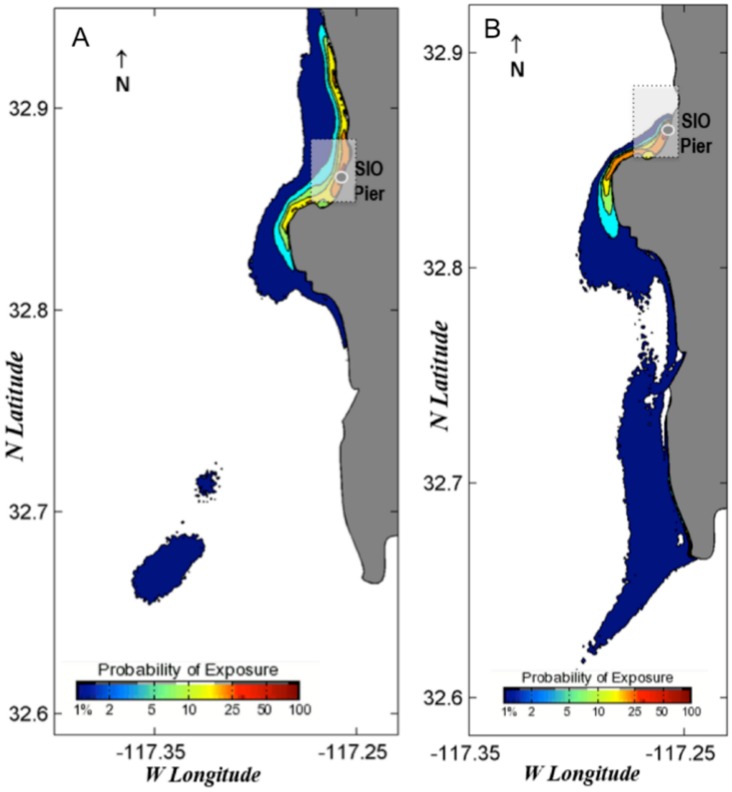
Probability maps of predicted larval fish dispersal.Both maps show the results of the predictive model run for twenty days following a collection date to visualize the probable distribution of larvae after hatching. The white box denotes the approximate boundaries of the MPAs. Dates are (A) June 19-July 9, 2013 and (B) February 4–25, 2014.